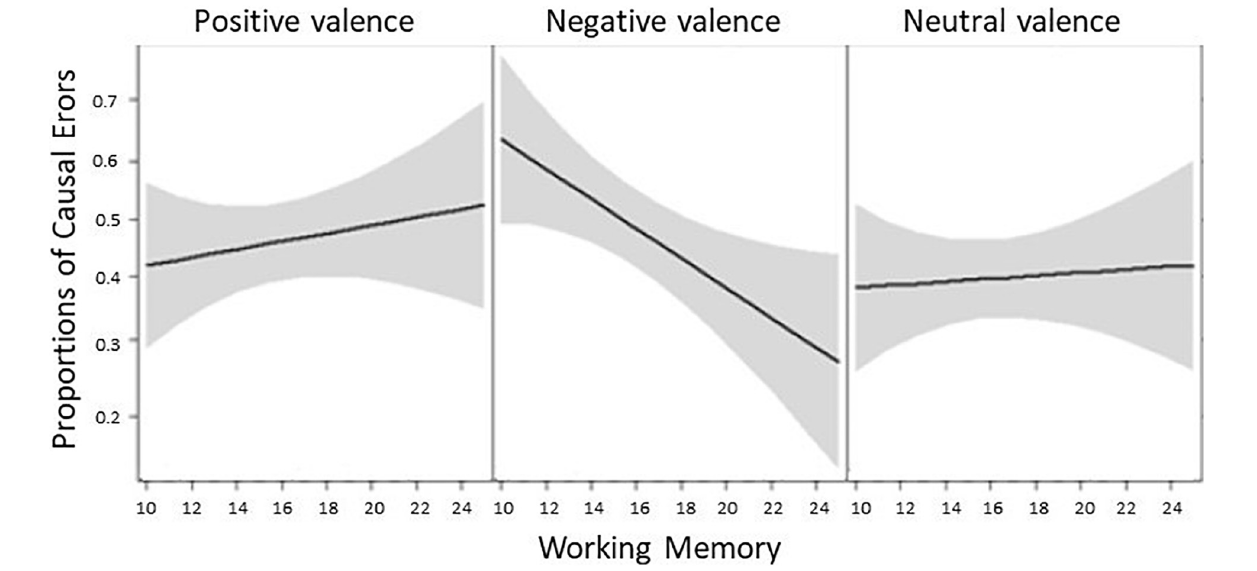
FIGURE 1 | Mean proportions of false memories (i.e., causal errors) as a function of emotional valence (i.e., positive, negative, and neutral) and WM abilities. Shaded gray areas represent 95%